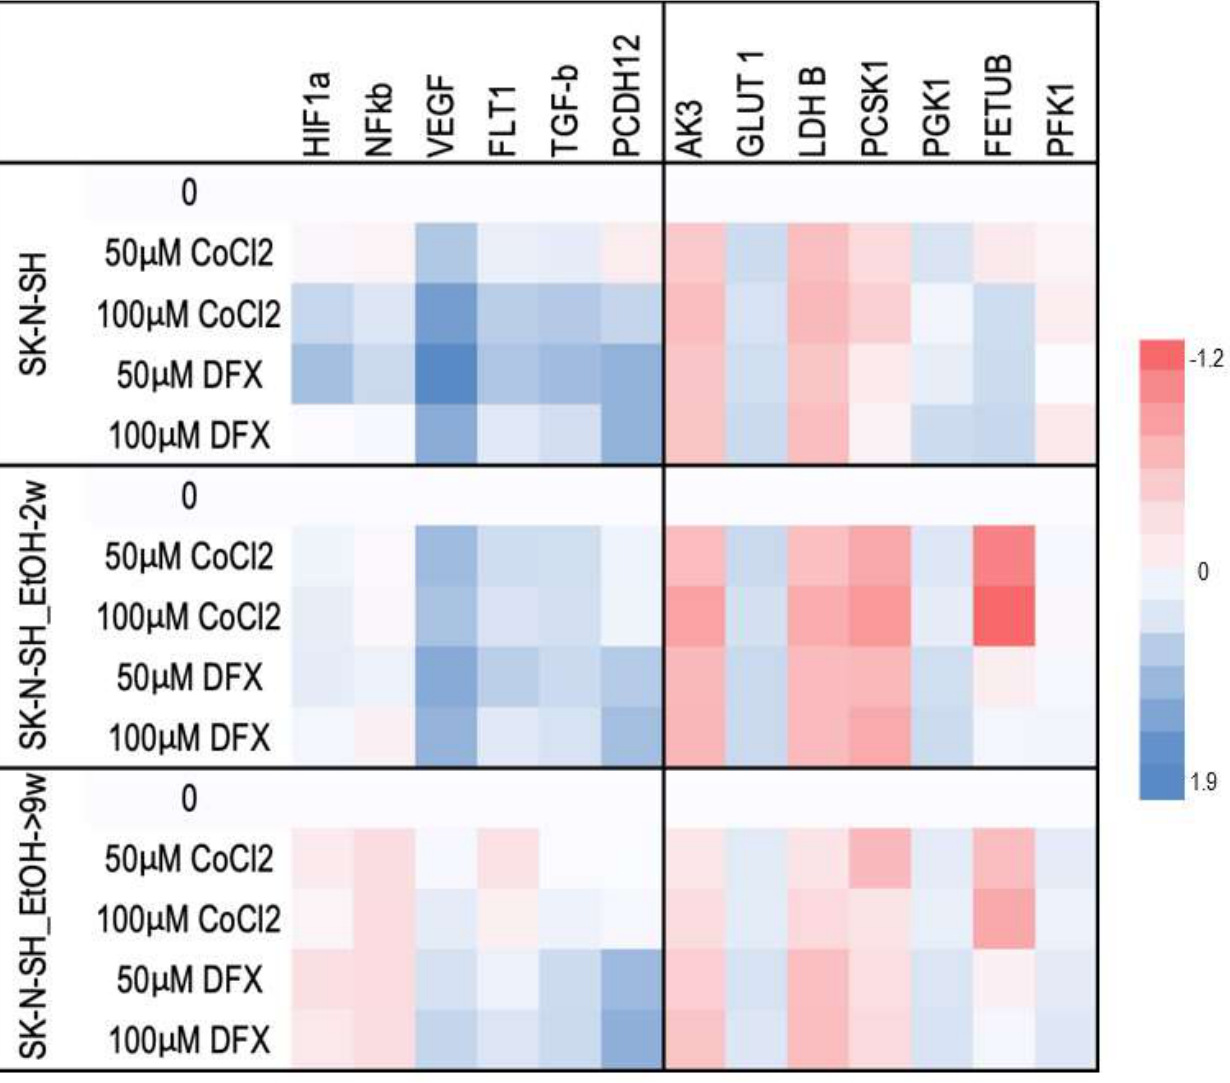
Figure 6. Heatmap analysis of stress and metabolic gene expression profile induced by DFX and CoCl 2 on ethanol-exposed SK-N-SH cells. Each numerical data was graphically represented using warm colours representing low-value data points and cool colours representing high-value data points.